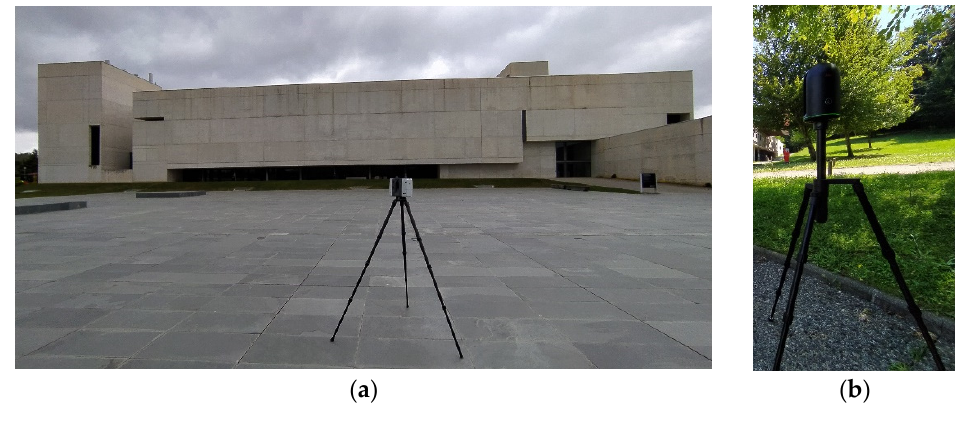
Figure 6. Scanners used: ( a ) RTC 360; ( b ) BLK 360.